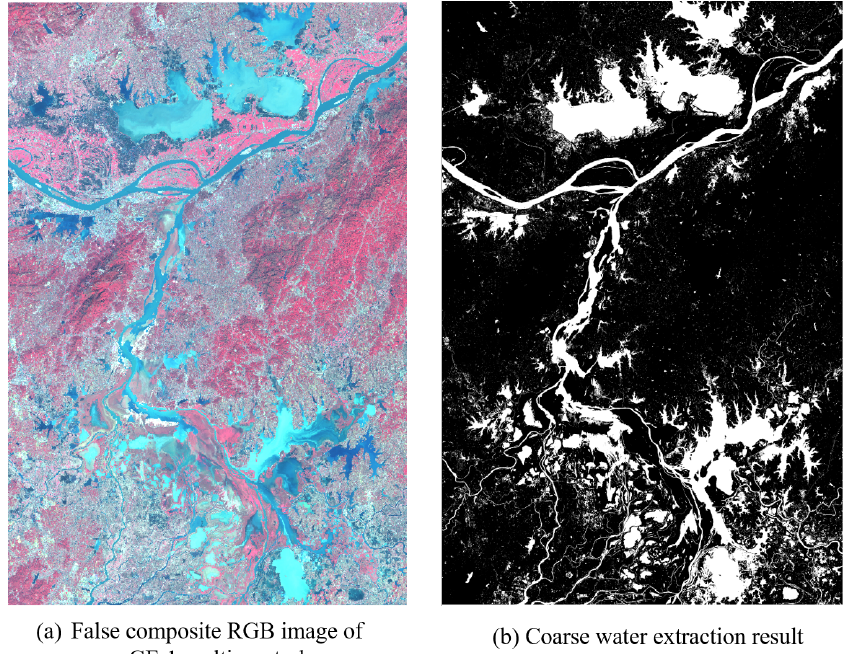
Figure 9. Coarse water extraction of GF-1 multispectral.